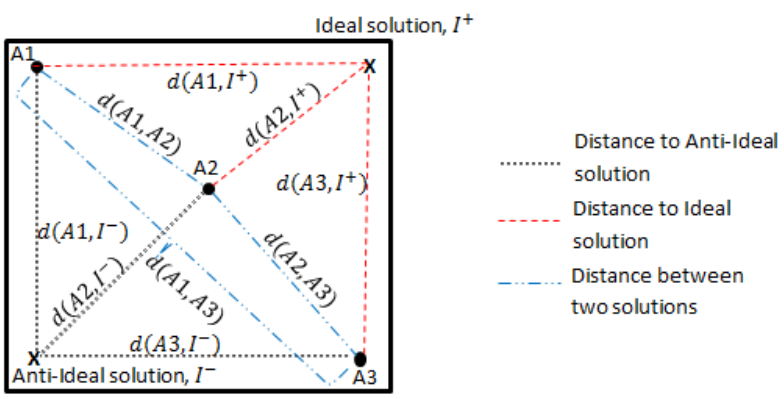
Figure 3. Distance measurement in TOPSIS and trade-off